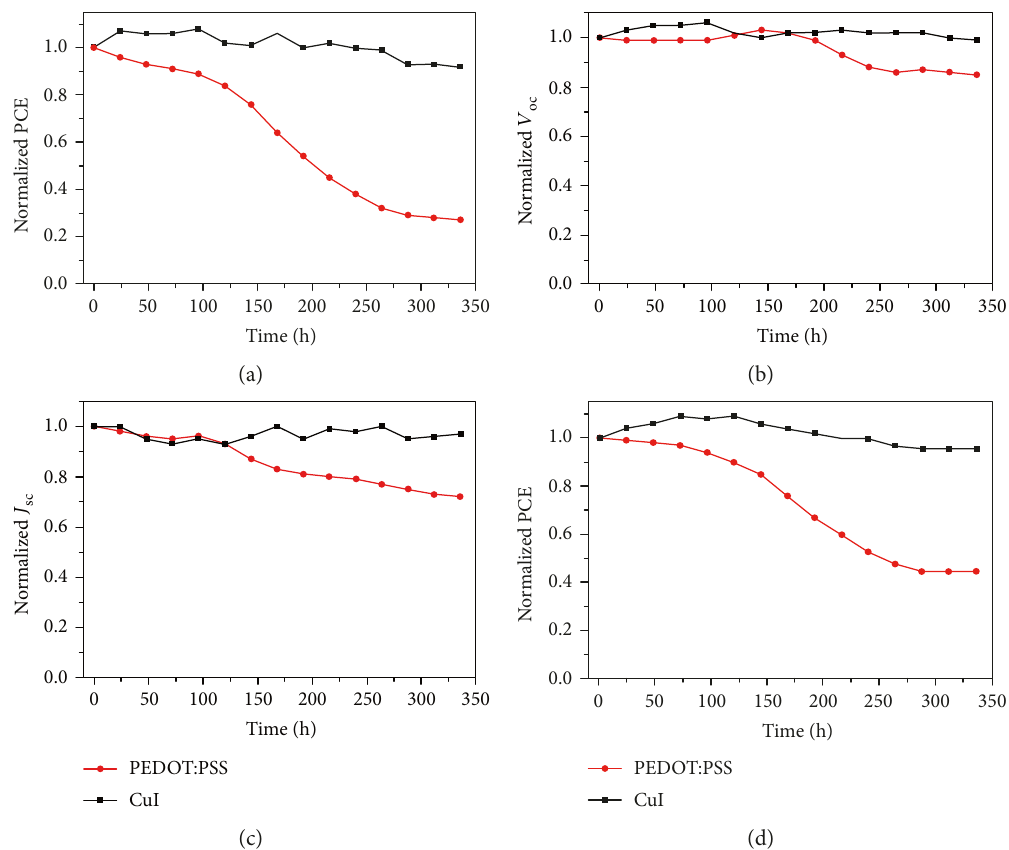
Figure 6: Normalized PCE (a), V storage time in air. Reprinted with permission from